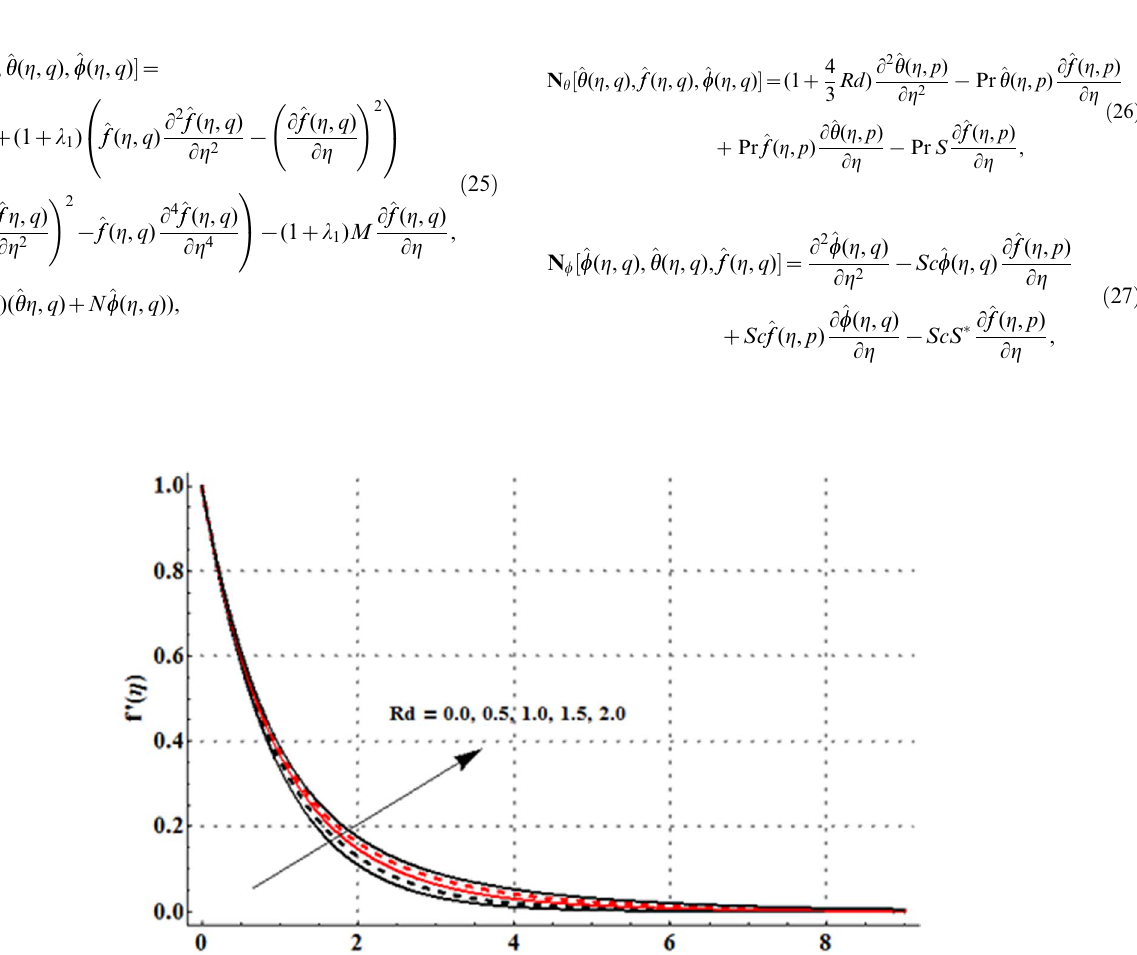
Figure 7. Influence of N on the velocity profile f ’ ( g ) when M ~ 0 : 6, b ~ 0 : 4 ~ Rd , l 1 ~ 0 : 5, l ~ 0 : 3, Pr ~ 1 : 2, S ~ 0 : 2 ~ S (cid:2) and Sc ~ 1 : 0 :